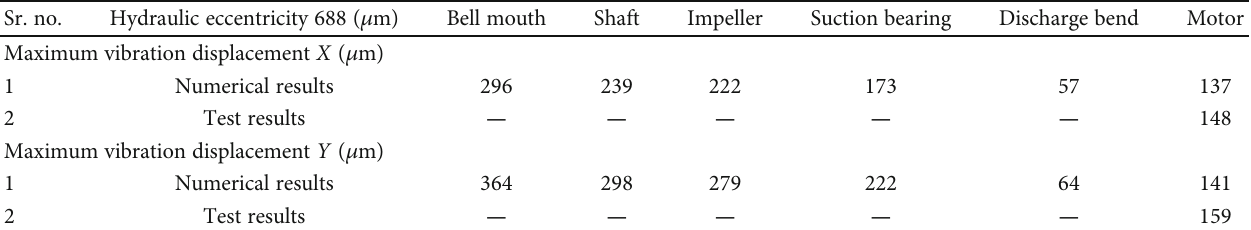
Table 3: Vibration displacements when impeller is with hydraulic unbalance.